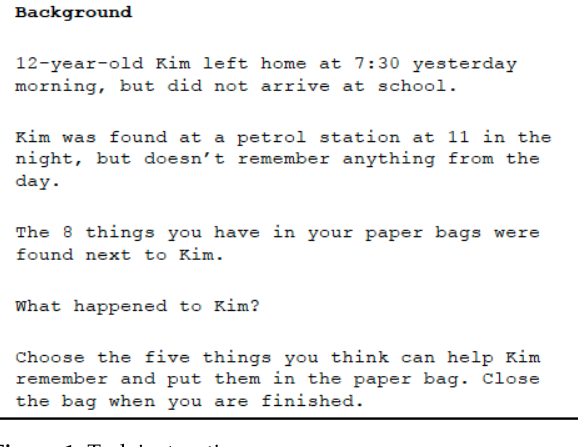
Figure 1. Task Figure 1. Task instructions.